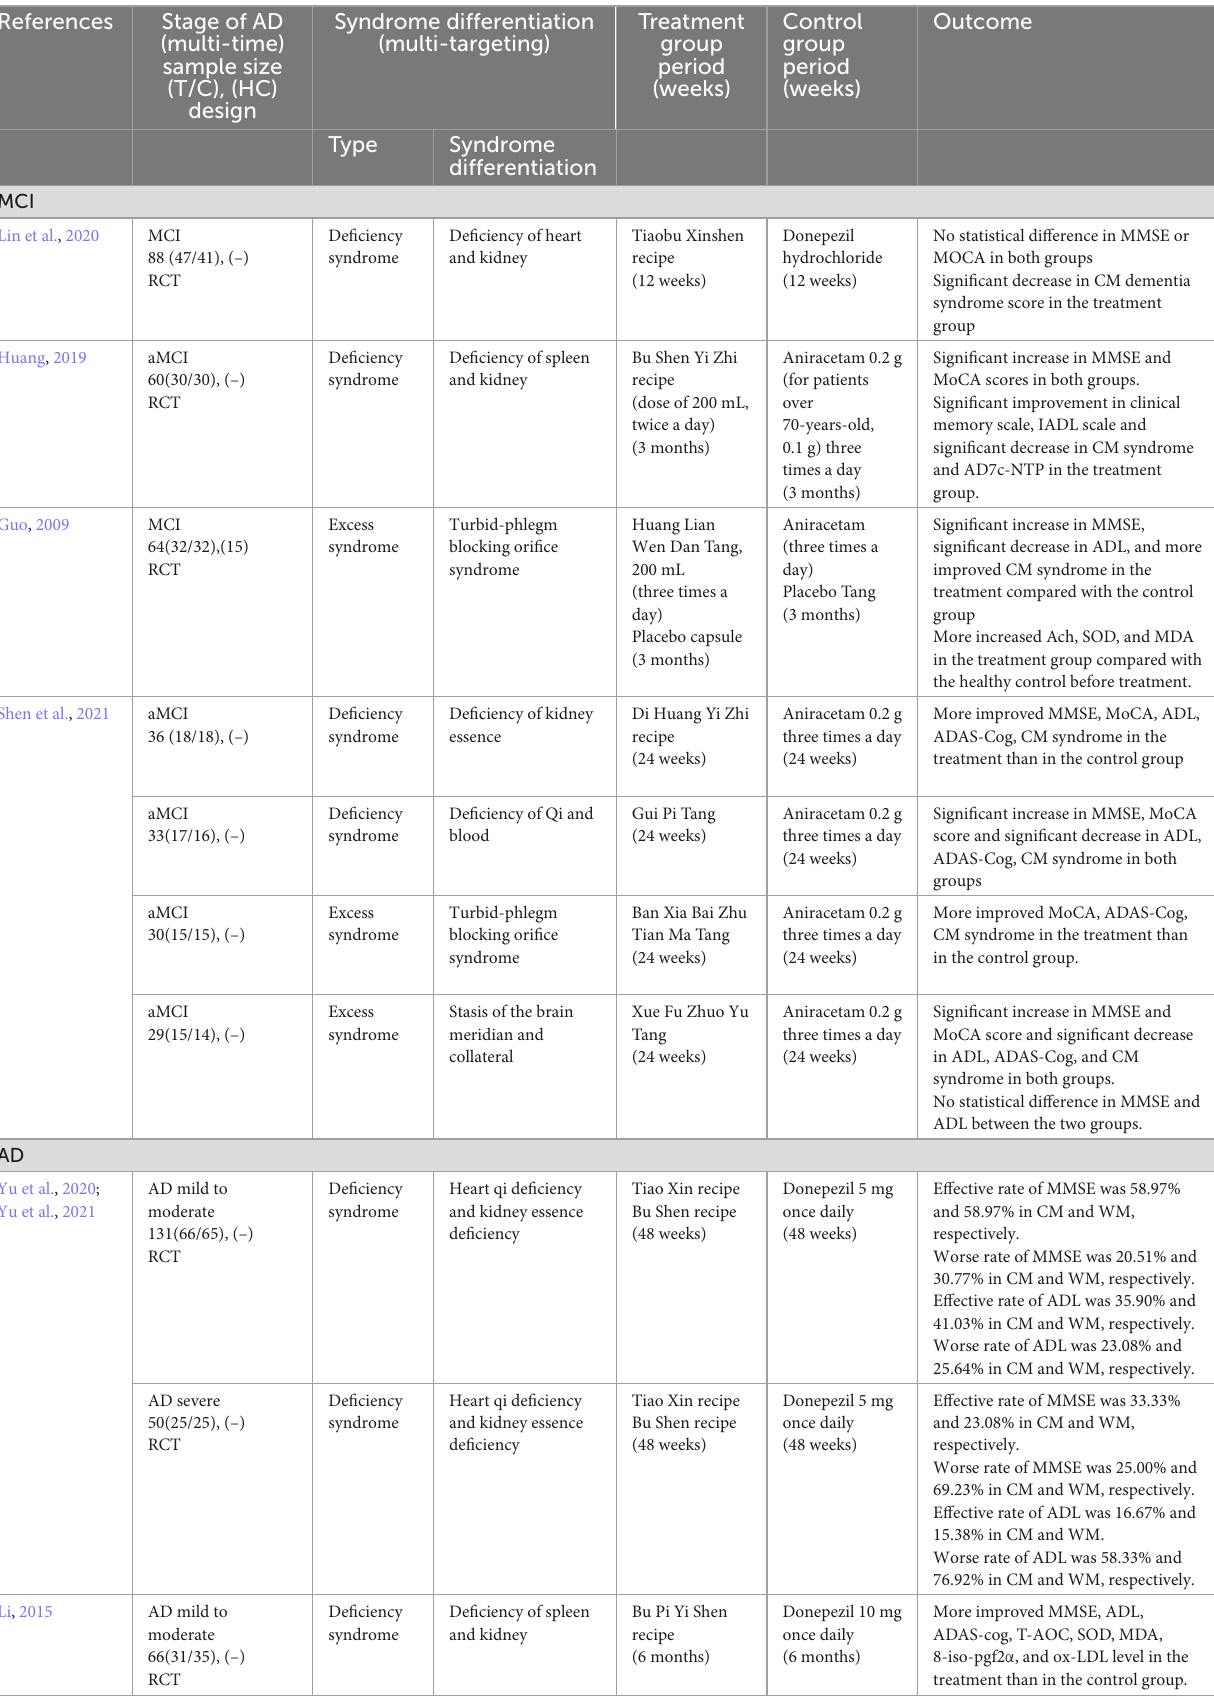
TABLE 1 Summaries of the included clinical research with representative syndrome differentiation in patients with cognitive